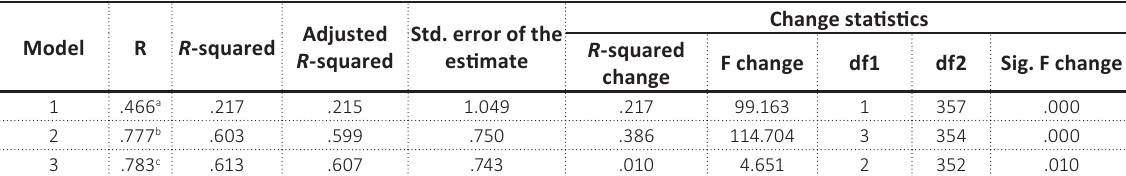
Table 5. The development of the determination coefficient value ( R